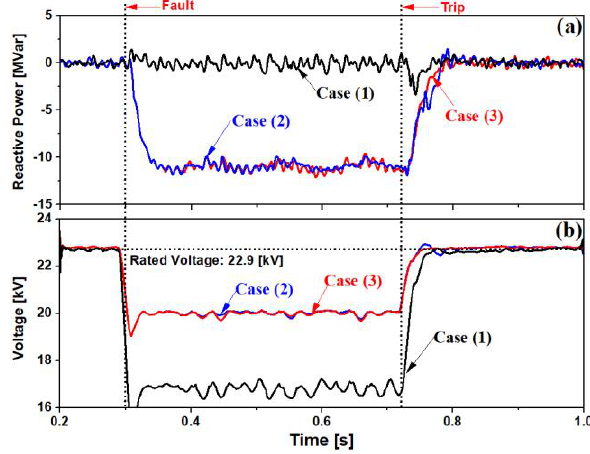
Figure 11. Simulation Results in Case (1)-(3): ( a ) Reactive Power of VSC (Voltage-Sourced Converter); ( b ) AC Power System RMS (Root Mean Square) ( b ) AC Power System RMS (Root Mean Square) Voltage.